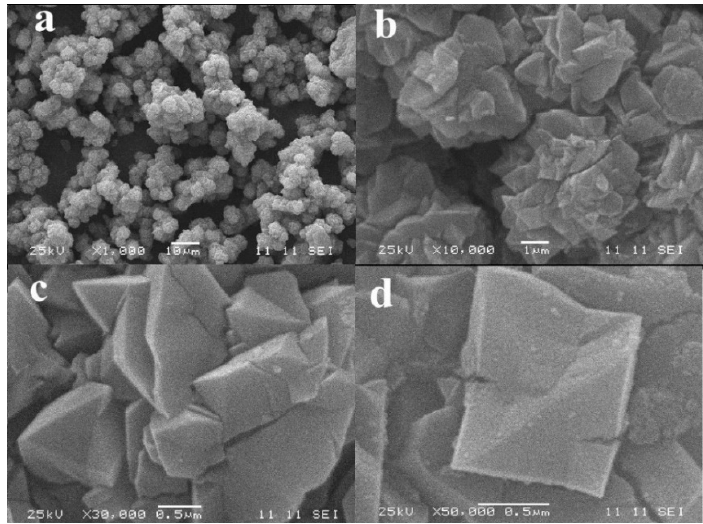
Figure 8. SEM images of porous alumina prepared via alkali leaching of kaolinite activated at 1150 °C for 15 min. ( a ) ×1000; ( b ) ×10,000; ( a ) ×30,000; ( b ) ×50,000.